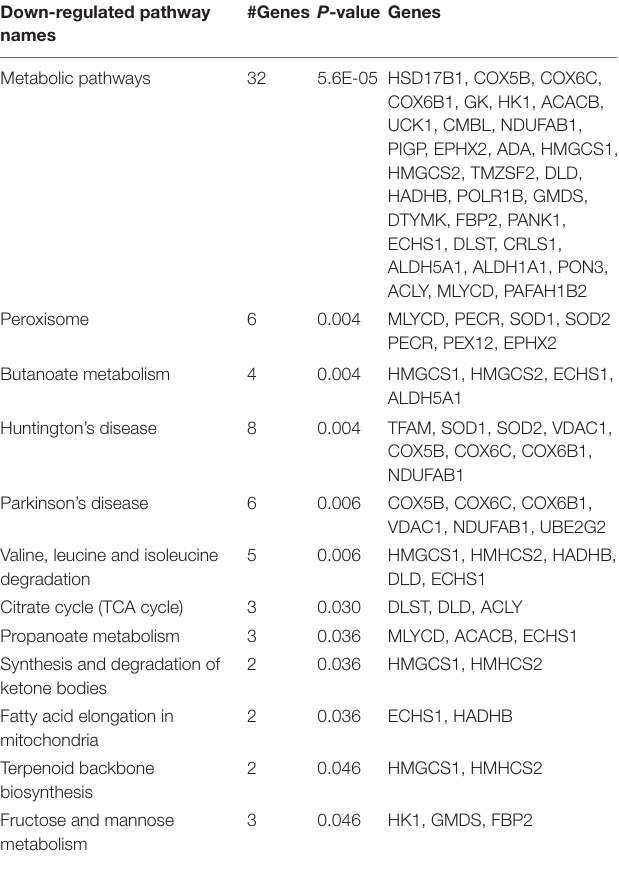
TABLE 3 | KEGG pathways significantly overrepresented in downregulated genes in EAT of 2-week-old lambs from cortisol-treated (0.5 mg/kg/day) ( n = 9 lambs, 4 male and 5 female) compared to lambs of control ewes ( n = 7, 3 male and 4